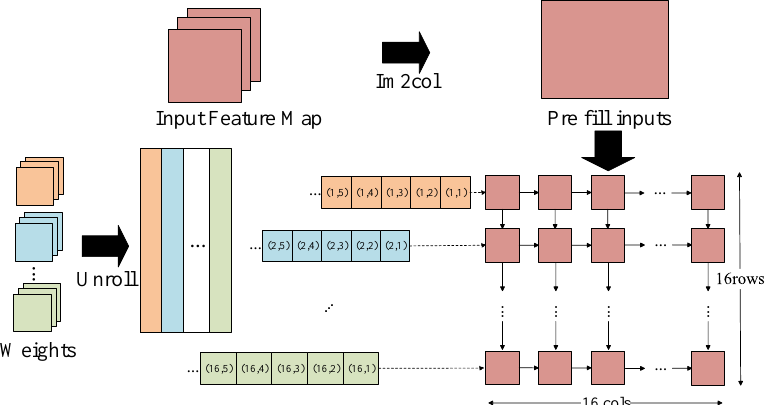
Figure 4. Example of simulating affine function. The example uses input stationary dataflow. If the workload is convolution, it is converted to GEMM by